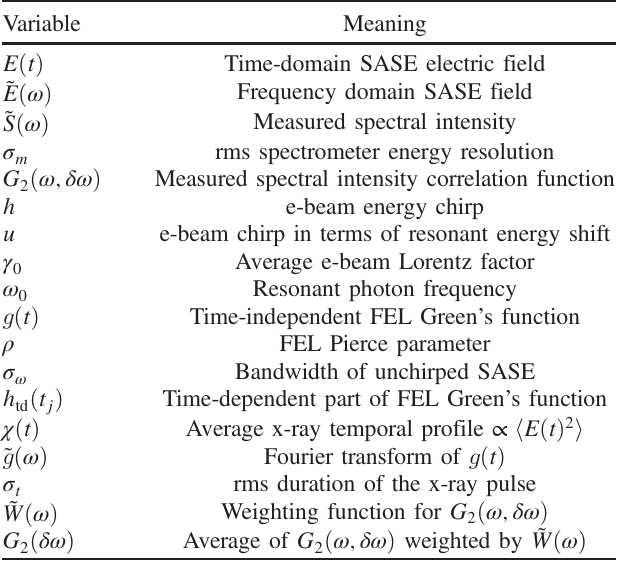
TABLE I. Key variables used throughout the